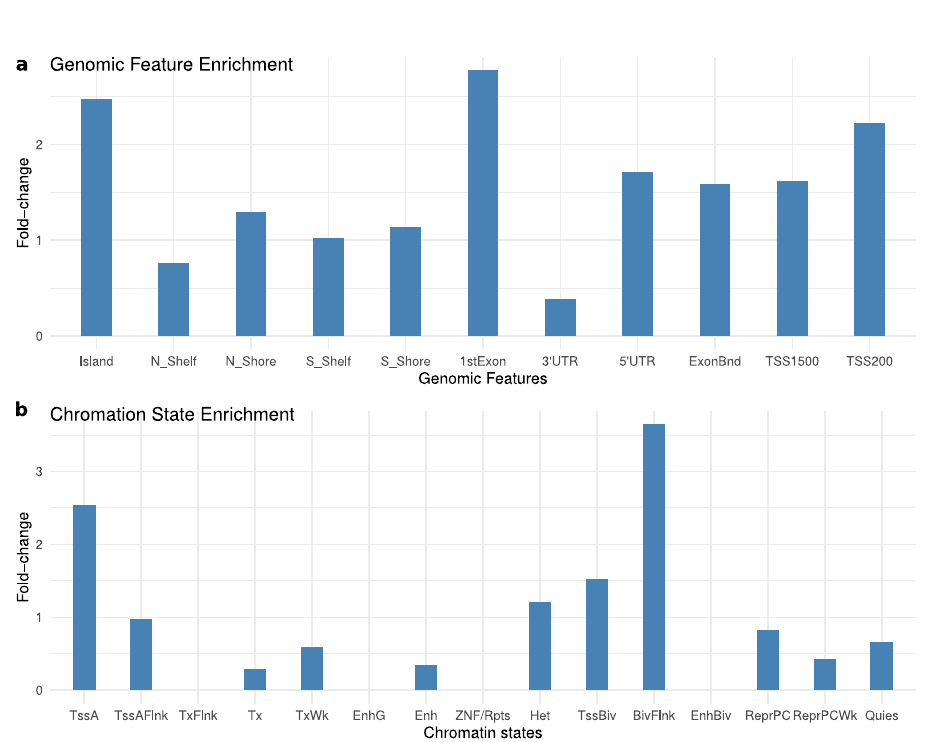
Fig. 3 Genome feature annotation of DLB-associated DMCs. a Genomic features and b chromatin states enrichment analysis of the DMCs at q-value <